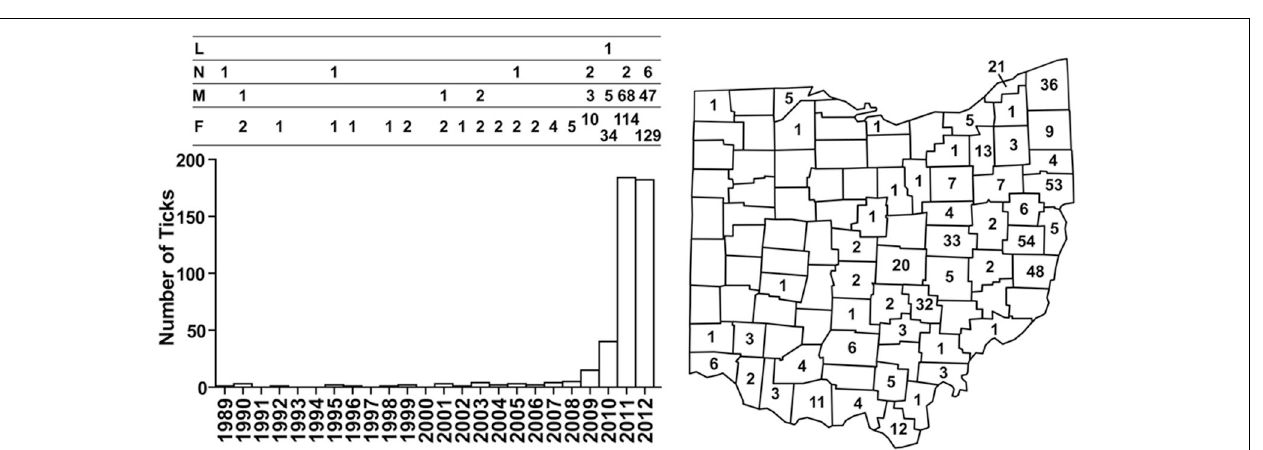
FIGURE 1 | Numbers and distribution of I. scapularis collected through the ODH tick surveillance program from 1989 to 2012. Numbers of I. scapularis ticks are plotted according to year and the development stages of